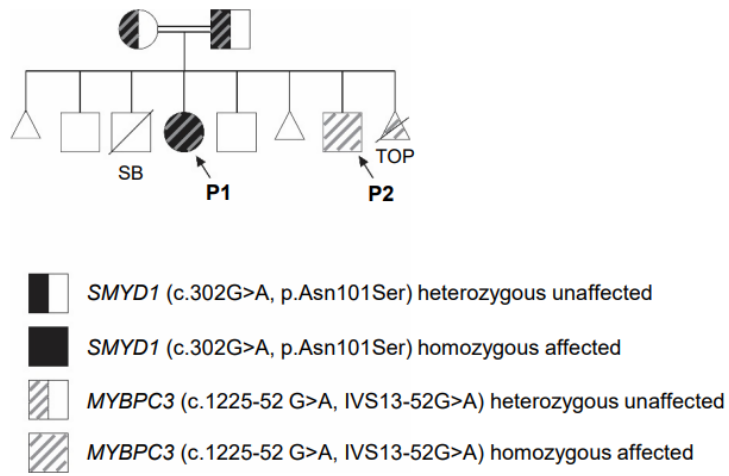
Figure 1. Pedigree of the family carrying the SMYD1 (c.302A>G; p.Asn101Ser) variant and MYBPC3 c.1224-52 G>A (IVS 13-52G>A) variant. Females are represented by circles, males are represented by squares, miscarriages are represented by triangles, termination of pregnancy (TOP) is represented by a triangle and diagonal line, diagonal line indicates deceased and double horizontal lines indicate consanguinity. Both parents are unaffected and heterozygous for both variants, while P1 is homozy- gous for both SMYD1 and MYBPC3 variants and P2 is homozygous for the MYBPC3 variant (arrows). TOP is homozygous for MYBPC3 . The two unaffected male children are not carriers for either gene variant. Male stillborn (SB) deceased at 7 months gestation was not tested.